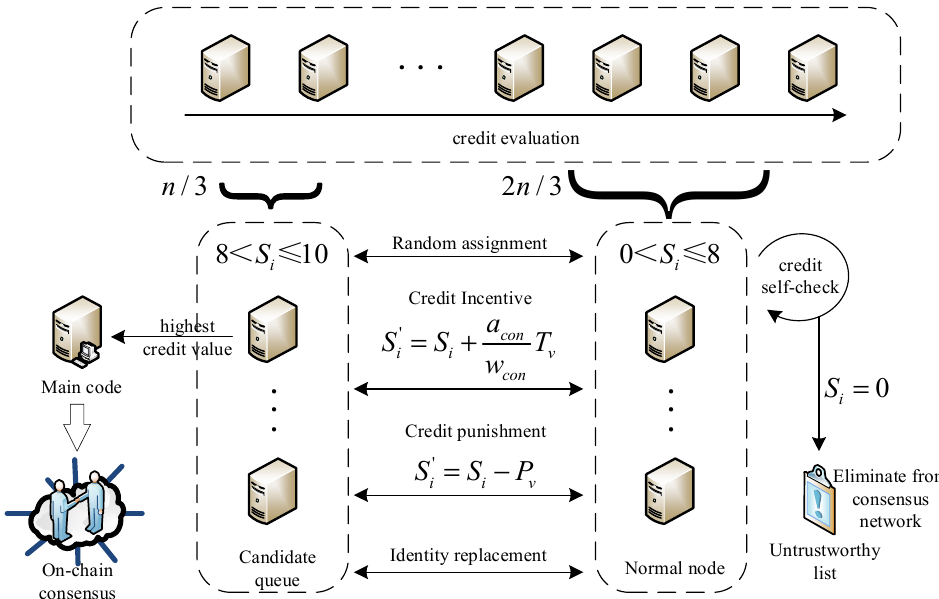
Figure 5. Node credit evaluation mechanism of CPBFT.